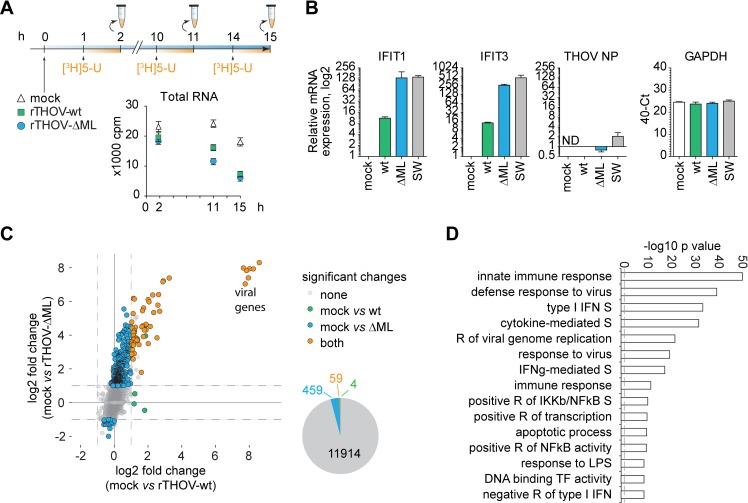
Transcriptome analysis of THOV-induced changes suggests broad but selective effect of ML.A) RNA synthesis rate in THOV infected Vero cells. Newly synthesized RNA was labelled with [3H]-5-Uridine at 1, 10 and 14 hours post infection. Presented is total RNA fraction as mean and SD from three technical replicates. B) qPCR analysis of IFITs, THOV NP transcript and GAPDH expression in HeLa cells after infection with THOV-wt, THOV-ΔML and THOV-SW for 16 hours. Presented are means and SD from three independent infection experiments. C) 2D-scatter plot of transcriptome analysis of HeLa cells infected with THOV-wt, THOV-ΔML and THOV-SW for 16 hours in three biological replicates. X axis represents log2 fold changes between mock and THOV-wt (green dots), Y axis shows log2 fold changes between mock and THOV-ΔML (blue dots). Changes occurring in wt and ΔML infections are shown in orange. Unchanged genes are shown in grey. Numbers are presented in a pie chart. Differentially regulated genes were showing at least 2-fold change with a q value < 0.05. D) GO term over-representation analysis of differentially upregulated genes by THOV ΔML and THOV ML (SW/AA) compared to THOV wt performed with InnateDB analysis tool. S–signalling, R–regulation, TF–transcription factor.